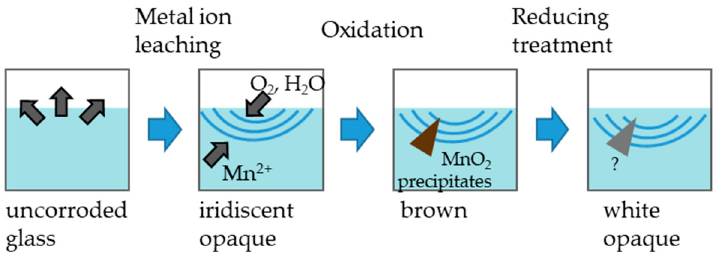
Figure 6. Example of surface corrosion in Mn-based glass, which cause the formation of iridescent patina and deposition of brown MnO 2 precipitates.